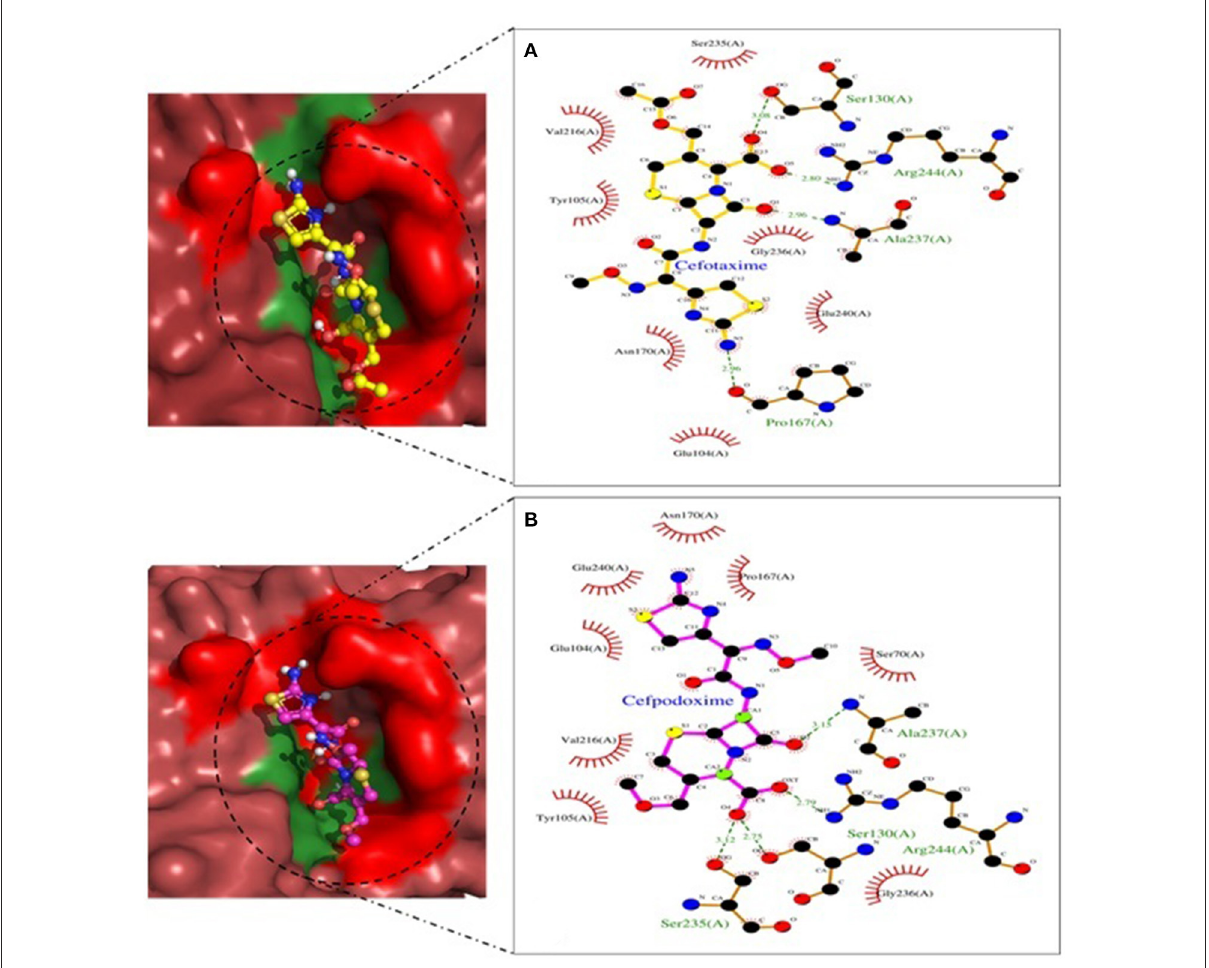
FIGURE10 TEM-1 involved in interactions. (A) A binding map for cefotaxime + TEM-1. (B) A binding map for cefpodoxime +